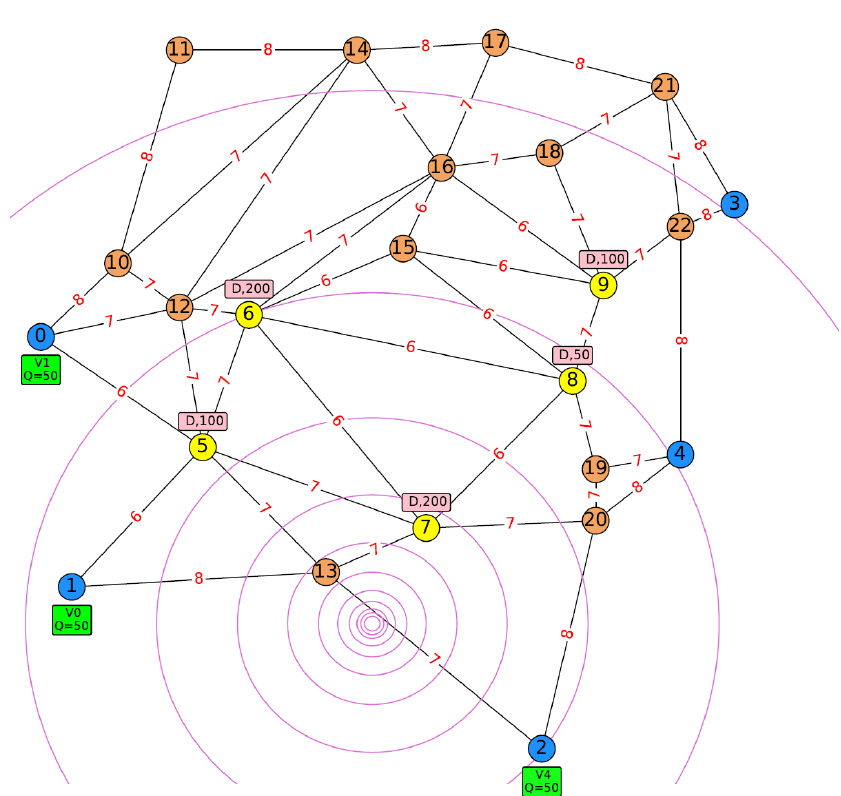
Figure A3. Road network for instance D5N13S5